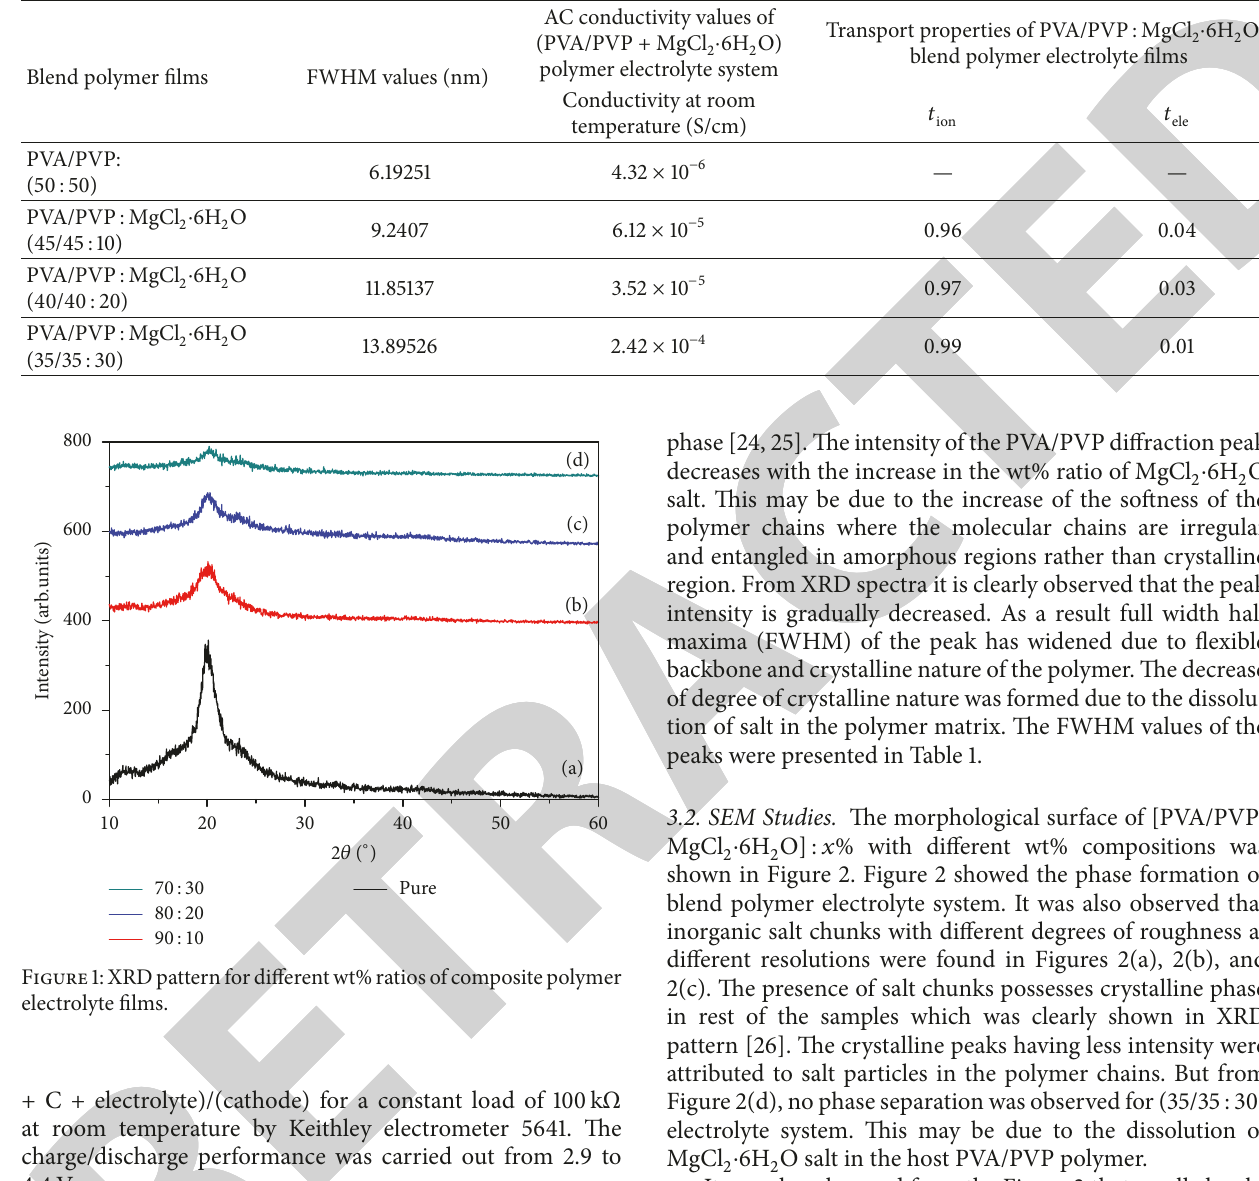
Table 1: FWHM, AC conductivity, and transport values of polymer electrolyte films for different wt% ratios.